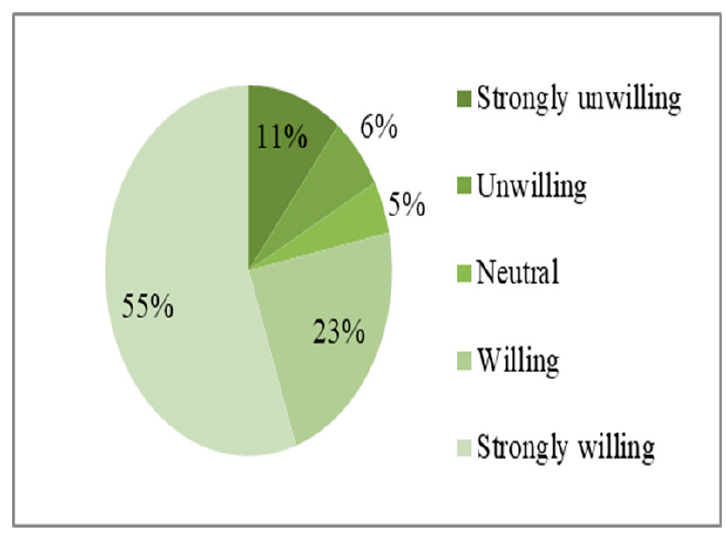
Figure 4. Frequency distribution map of residents’ relocation willingness.